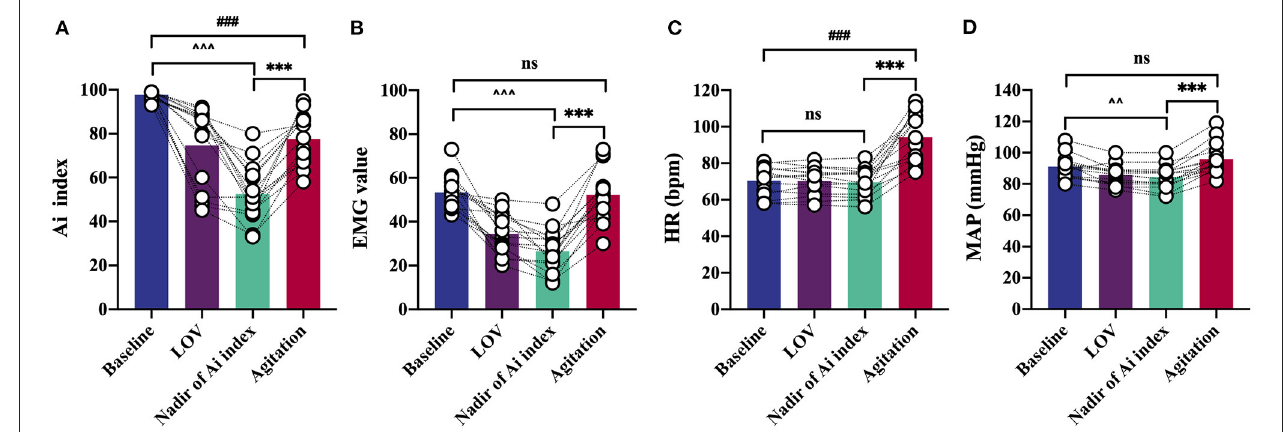
FIGURE 3 | Detailed analysis of characteristic changes of the Ai index, EMG, HR, and MAP in agitation ( + ) group ( n = 15). Ai index (A) , EMG (B) and MAP (D) decreased before agitation. Ai index, EMG, HR (C), and MAP increased during agitation period. Data are expressed as mean ± SD; *** p < 0.001; ### p < 0.001; ∧∧ p < 0.01, ∧∧∧ p < 0.001; ns, not significant; Repeated measures analysis of variance using Bonferroni post hoc tests (A–D) . EMG, electromyography; Ai index, the depth of anesthesia index; MAP, mean arterial pressure; HR, heart rate; LOV, loss of verbal; LOTS, loss of response to trapezius